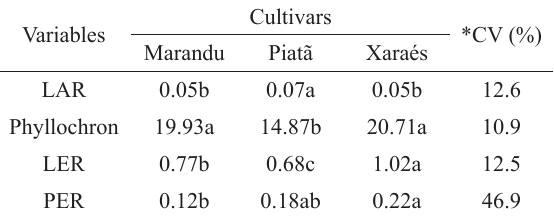
Leaf appearance rate (LAR) in leaves/tiller/day, phyllochronin day/leaf/tiller of B. brizantha cultivars fertilized with increasing nitrogen rates, leaf elongation rate (LER) in cm/tiller/day